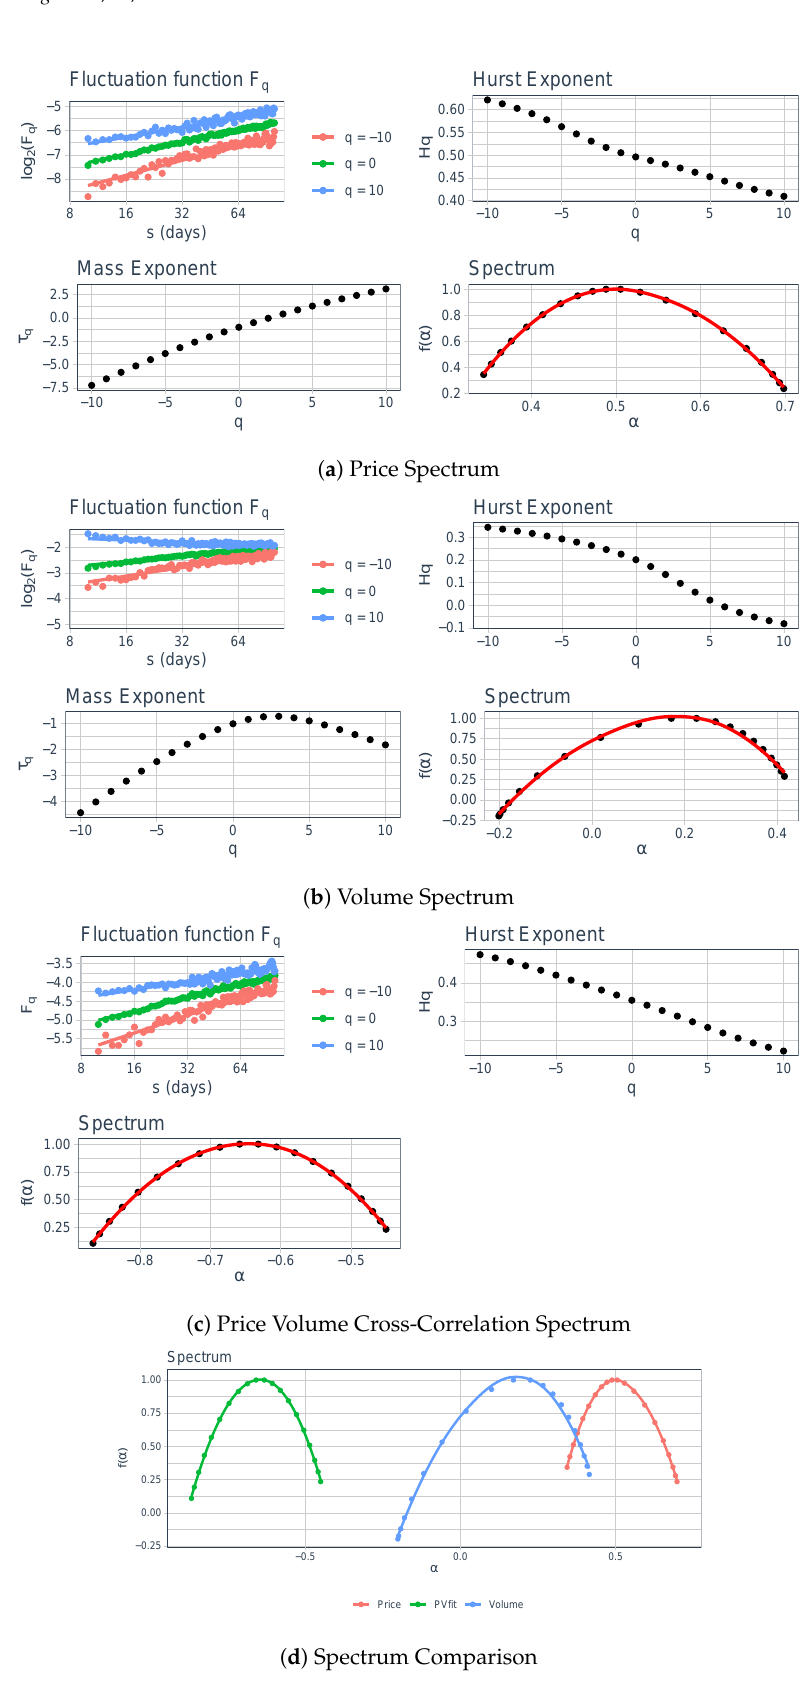
Figure 9. Segment 5 price, volume, and price-volume cross-correlation